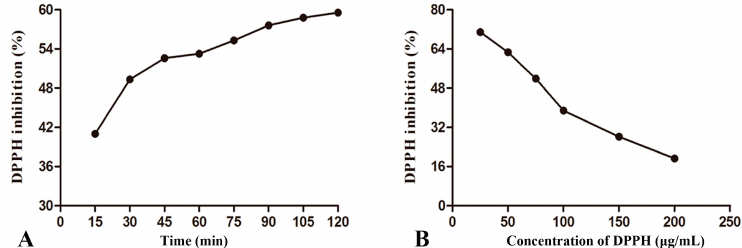
Figure 4. The single-factor study of DPPH assay ( A : reaction time B : DPPH concentration).